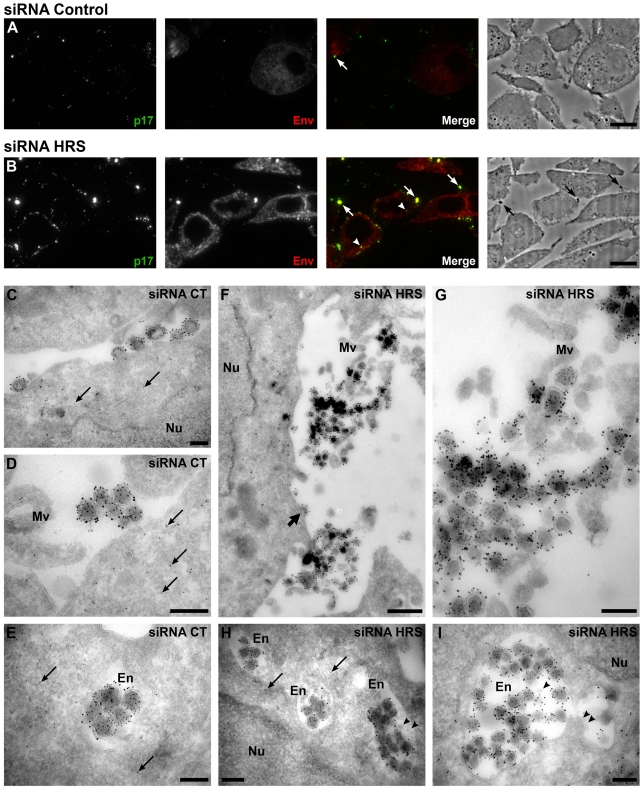
Silencing of HRS leads to accumulation of HIV-1 particles in at the cell surface and in endosomes.HeLa cells transfected with either siRNA control (A and C–E) or siRNA targeting HRS (B and F–I) were infected with VSV-G-pseudotyped HIV-1 for 48 hrs, fixed and prepared for cryosectioning. (A, B) Immunofluorescence analysis of MAp17 and Env distribution on semi-thin cryosections. Semi-thin (0.5 µm) cryosections were immunostained with mouse anti-MAp17 and anti-mouse-Alexa-488 (green) and 2G12 anti-HIV-Env and anti-human- Alexa-594 (red). MAp17 staining reveals fine spots probably representing virus particles at the surface of the cells, as well as larger clumps of virus staining (arrows) which can correspond to phase-dark structures at the surface of the cell profiles in the phase images shown in the right hand panels. Many more clumps of MAp17 staining were observed on the HRS-depleted cells (B). In addition, some virus staining was seen in intracellular vacuoles (arrowheads). Scale bars  = 10 µm. (C–I) ImmunoEM analysis of Gag and Env distribution. Ultrathin cryosections (50 nm) were labelled with anti-Gag p24/p55 (5 nm PAG) and anti-Env 2G12 (10 nm PAG). Infected cells show scattered 5 nm gold particles over the cytoplasm (thin arrows), but not over the nucleus (Nu). In the control cells immature and mature virus particles could be seen at the cell surface, individually or in small groups (C) or in small clumps (D) and, occasionally, in intracellular vacuoles (E). In cells treated with HRS siRNA, much larger clusters of HIV particles were seen at the cell surface or attached to microvillus-like cell surface protrusions (Mv) (F, the upper virus cluster is enlarged in G). In addition, intracellular vacuoles or endosomes (En) containing many virus particles were frequently seen (H, I). The thick arrow in F identifies a budding virus, and the arrowheads in H and I mark small intralumenal vesicles in the virus-containing endosomes. Scale bars in C–E and G–I  = 200 nm, F = 500 nm.